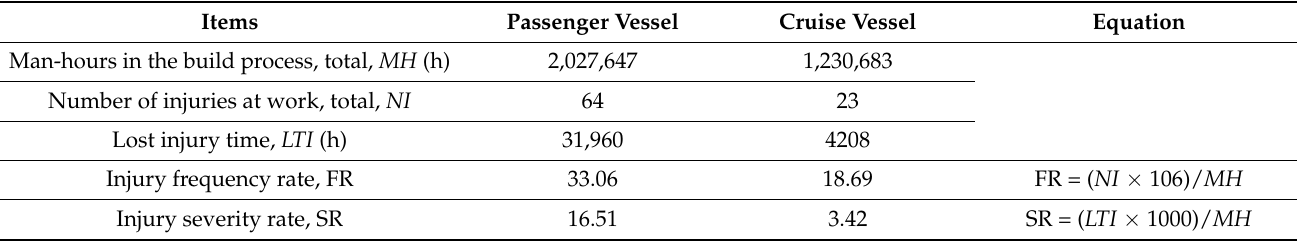
Table 4. Injuries at